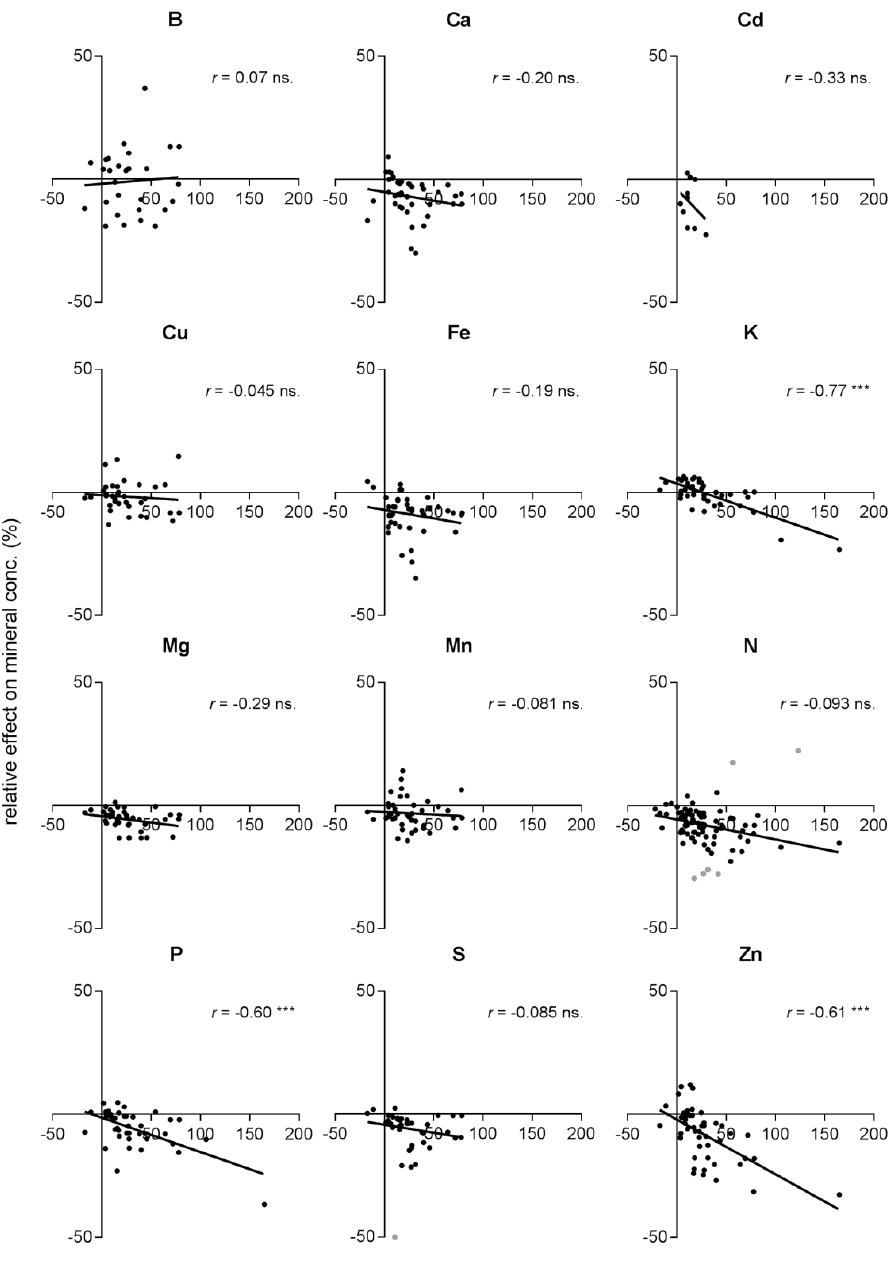
Figure 7. Relative effect of eCO 2 on the mineral concentration of B, Ca, Cd, Cu, Fe, K, Mg, Mn, N, P, S, and Zn vs. the relative effect on grain yield (g · m − 2 ). Black solid lines represent the linear regression model, for which parameters and model performance are presented in Table 2.